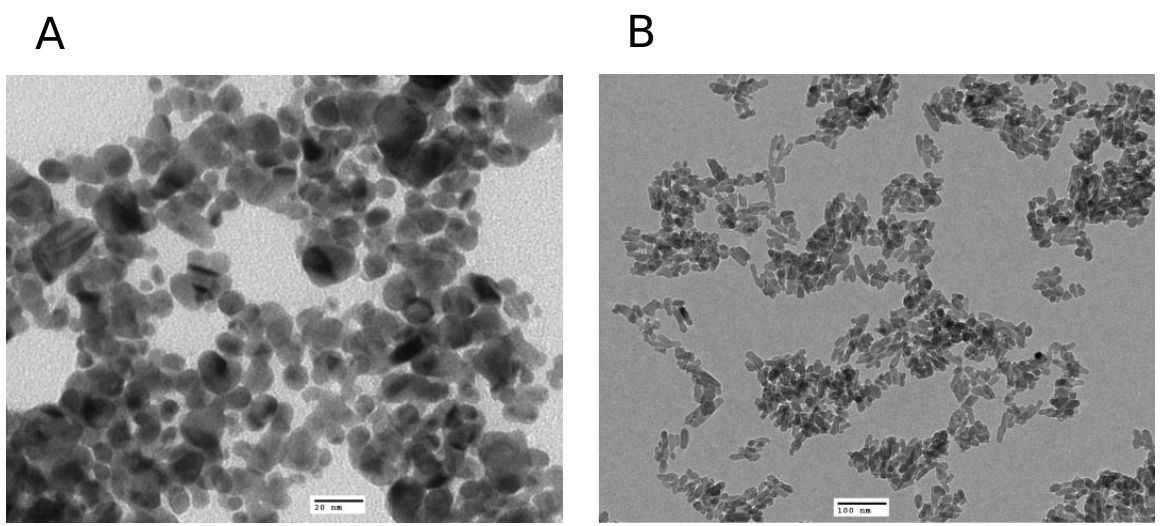
Figure 1. Characterization of the NPs used in this study by TEM analysis of ( A ) AgNPs, scale bar: 20 nm and ( B ) HANPs, scale bar: 100 nm.